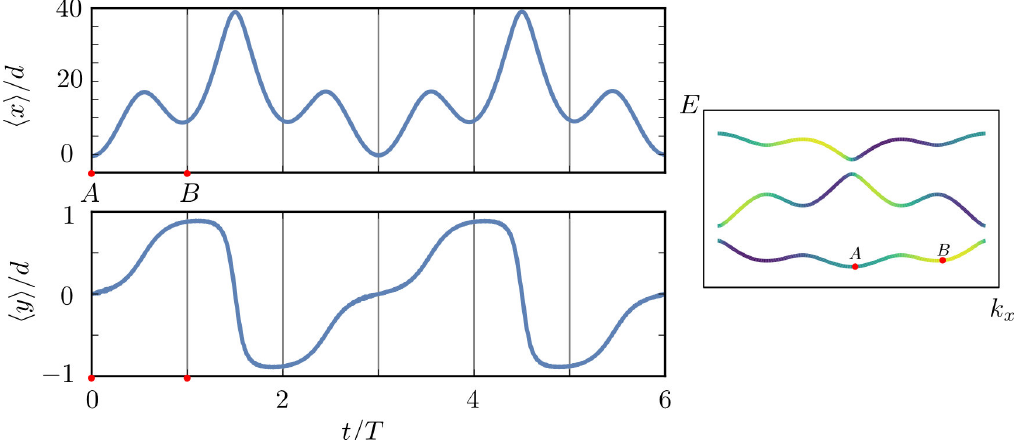
= J and y x = 1. Due to 1